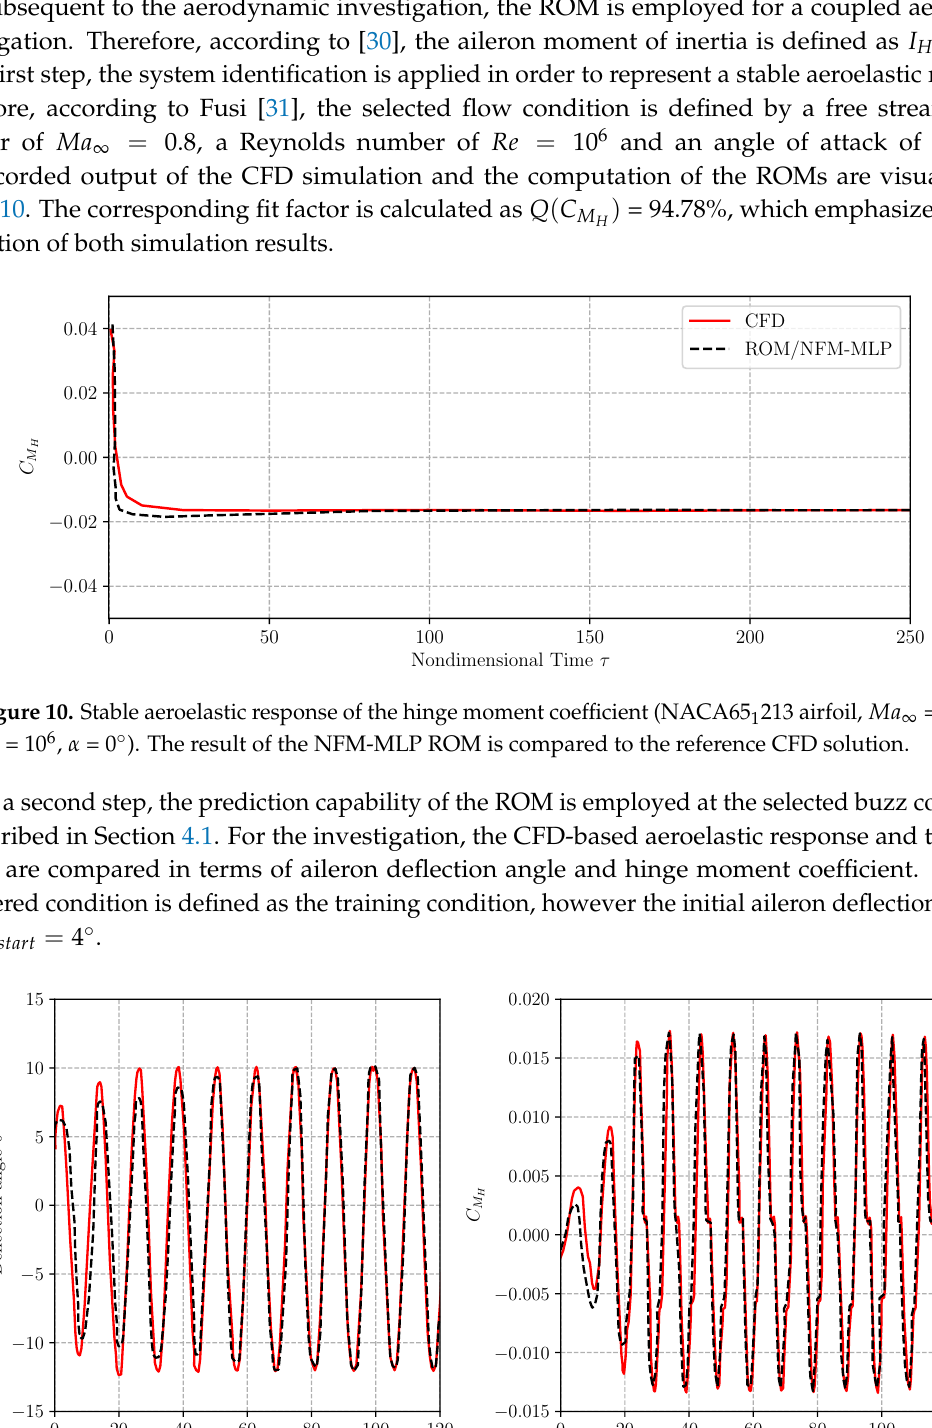
10 6 , α = 1 ◦ , δ start = 4 ◦ ). The results × − −